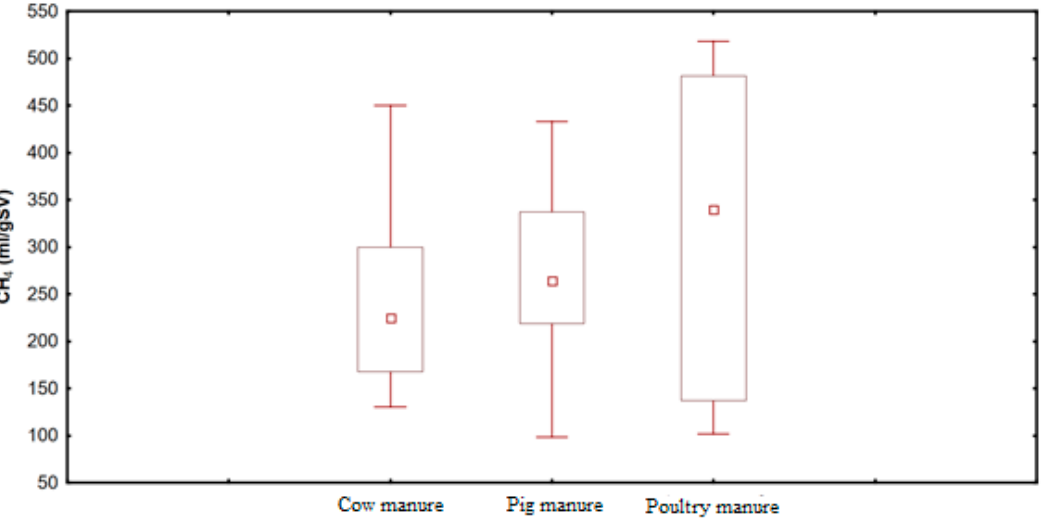
Figure 3. Box of whiskers from the production of pretreated methane from cow, pig and poultry manure.